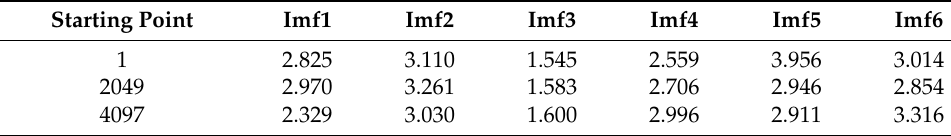
Table 6. The kurtosis value of each mode of normal.